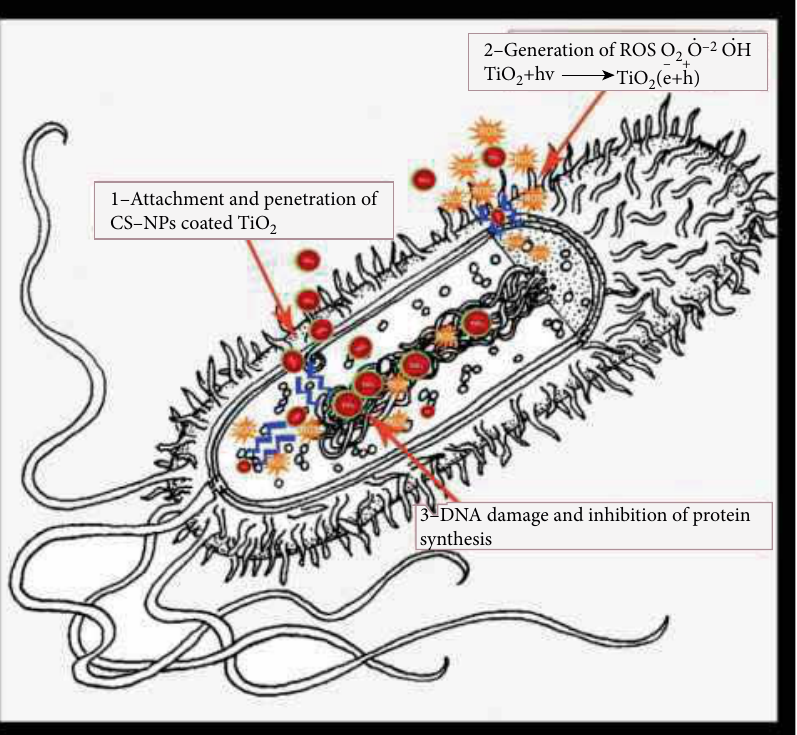
Figure 14: Proposed antibacterial mechanism of action of CS NPs coated TiO